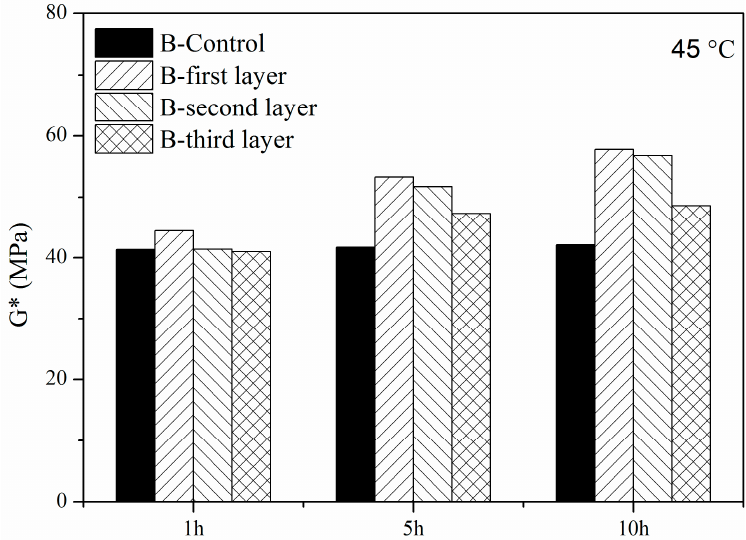
Figure 7. Complex modulus (45 °C) of B in different layers for different aging times.